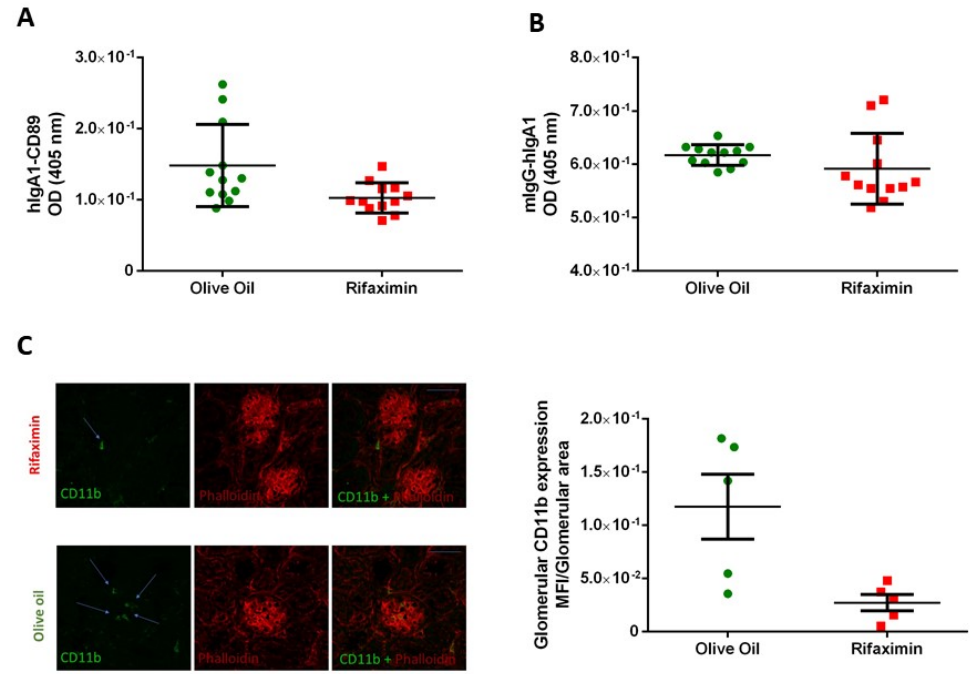
Figure 2 : Antibiotic treatment decreases the formation of hIgA1–sCD89 and of mIgG–hIgA1 complexes but not the hIgA1 serum level. ( A ) hIgA-CD89 complexes in mice that received rifaximin or olive oil. ( B ) Levels of mIgG-hIgA complexes in mice that received antibiotics or vehicle. Anti-hIgA or A3 monoclonal-antibody anti-human CD89 was used for coating. Polyethylene glycol precipitated sera were then added; detection with anti-hIgG or anti-hIgA-HRP. Serum hIgA1 and mIgG levels were measured by ELISA. Statistical analyses were performed using Mann–Whitney test. ( C ) Quantification of glomerular cells was performed by counting the area positive for CD11b measured using ImageJ. Representative sec- tions of kidneys after immunostaining with anti-CD11b-FITC antibody and Phalloidin–Alexaflour 564 to underline glo- merular structures (green anti CD11b, red phalloidin) and the ratio between the glomerular fluorescence area positive for CD11b and total area of the glomerulus, measured using ImageJ.